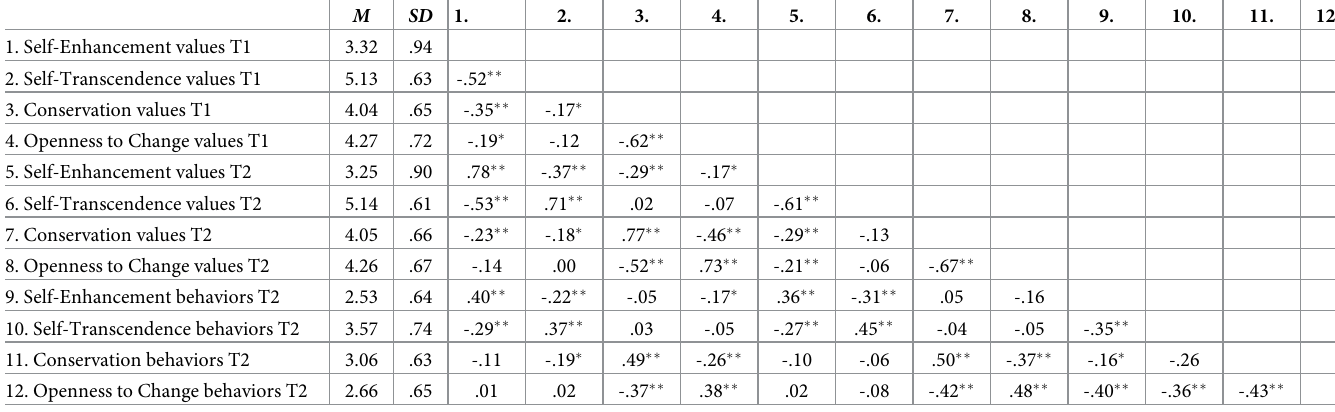
Table 1. Descriptive statistics: Means, standard deviations, and intercorrelations among values and value-expressive behaviors. M SD